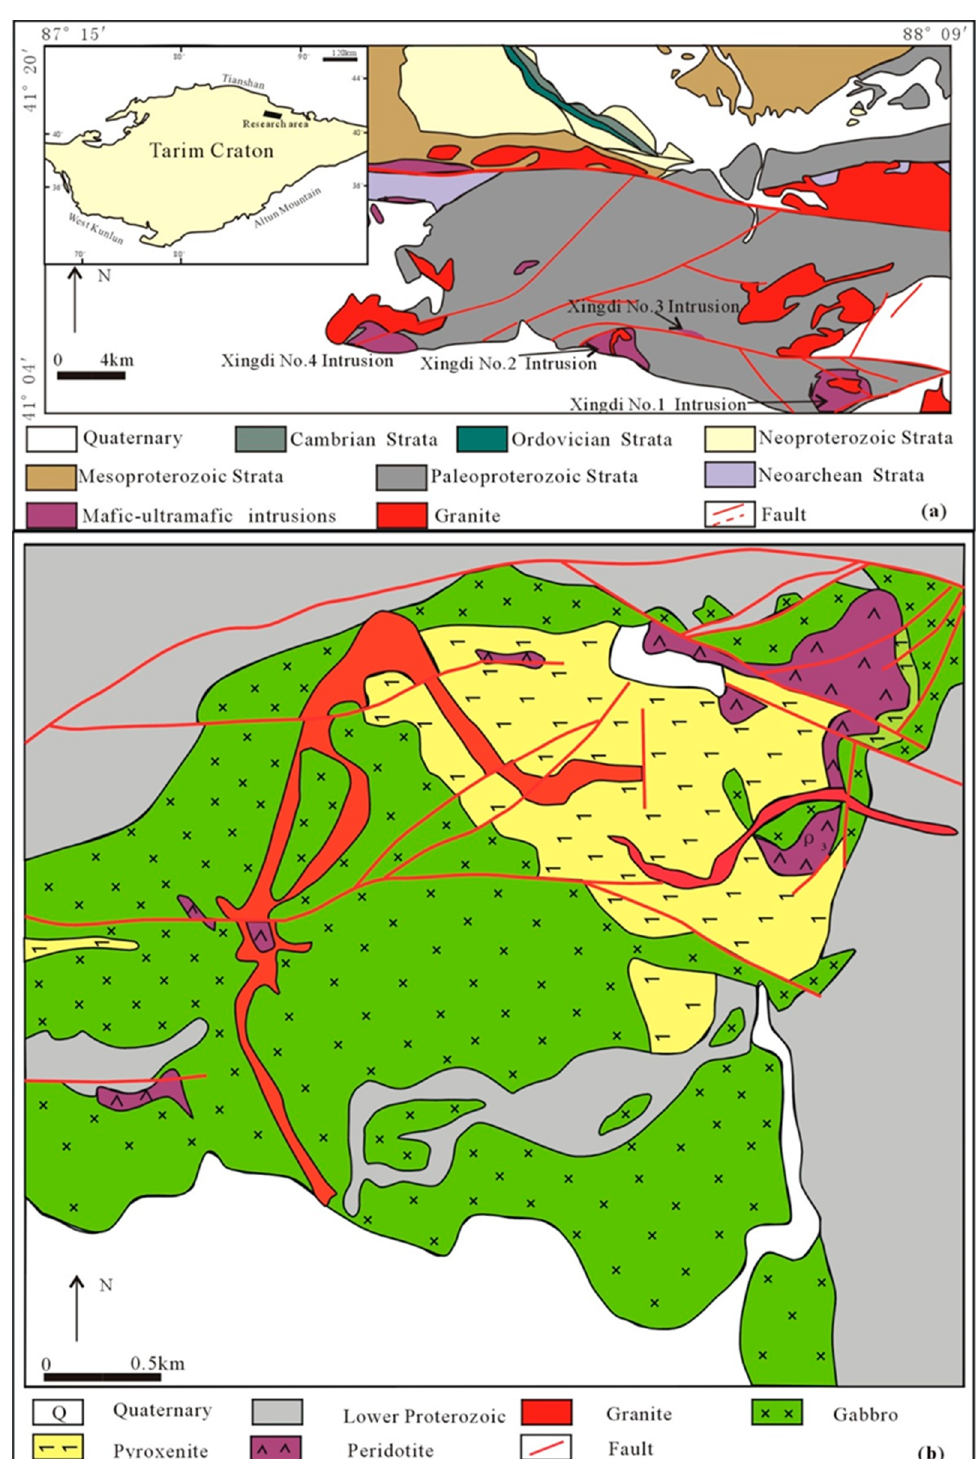
Figure 1. The regional geological map ( a ) and simplified sketch of the Xingdi No.2 Intrusion ( b ), Kuluktag area, Tarim Carton. Kuluktag area, Tarim